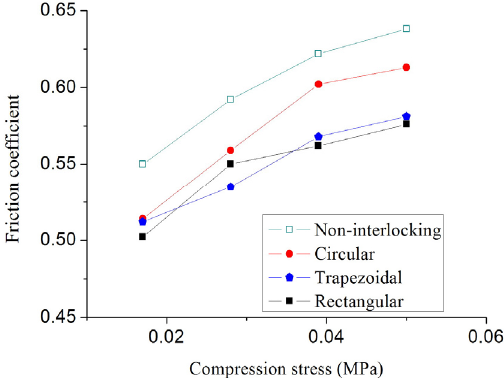
Figure 9. Effects of compression stress level on the friction coefficients.